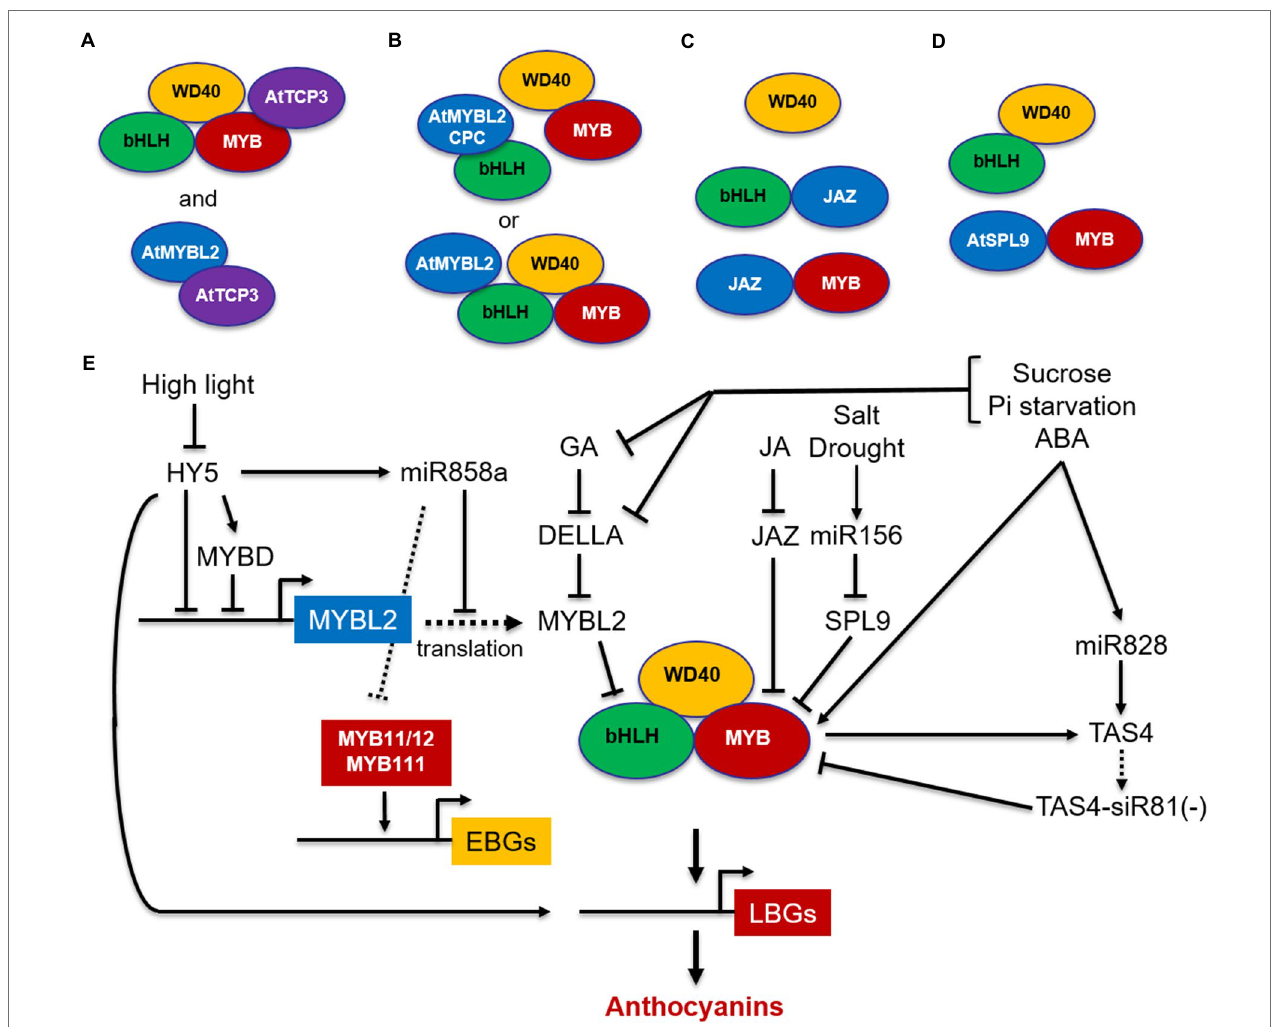
FIGURE 3 | Schematic model of positive and negative regulation of MBW complexes in Arabidopsis. The MYB-bHLH-WD40 (MBW) complex activates the expression of LBGs. (A) TCP3 stabilizes the MBW complex and reinforces its transcriptional capacity by associating with MYBs and by interacting with the MYBL2 repressor, thus preventing its binding to the bHLH proteins; (B) MYBL2 disrupts the MBW complex by interacting with bHLHs or participates in the MBW complex and down-regulates LBGs through its repression domain; (C) JAZ proteins disrupt the MBW complex by interacting with bHLHs or R2R3-MYBs; (D) SPL9 disrupts the MBW complex by interacting with MYBs; (E) simplified model for negative regulation of MYB11/12/111 genes and the MBW complex through MYBL2, JAZ, SPL9, and miRNAs. MYBs are indicated in red, bHLHs in green, and WD40s in yellow. TCP3 activator is indicated in violet, whereas MYBL2 and SPL9 repressors are indicated in light blue. Arrows, positive regulation; blunt ends, negative regulation; dashed arrow,